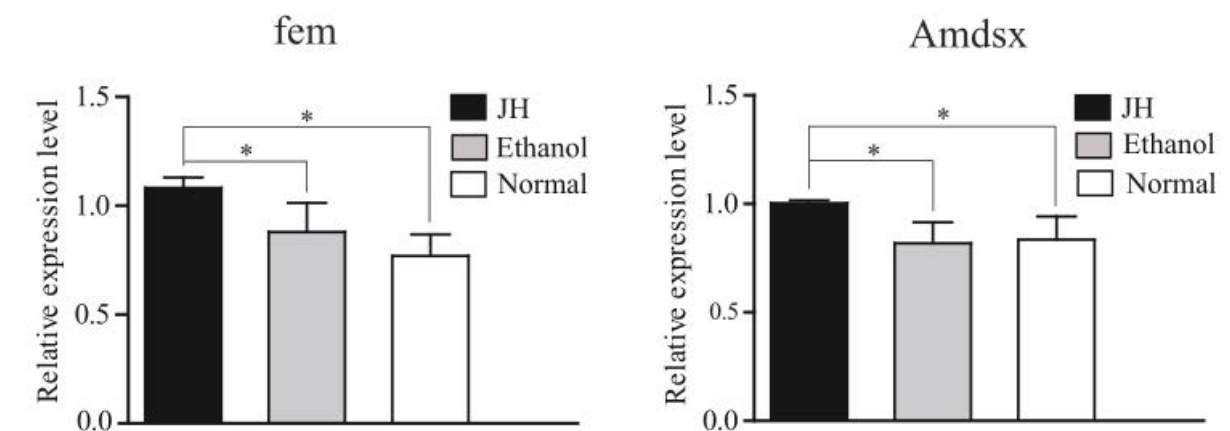
Fig 3 . Expression change of fem and Amdsx after JH III treatment. * represent significant difference (ANOVA, p<0.05).